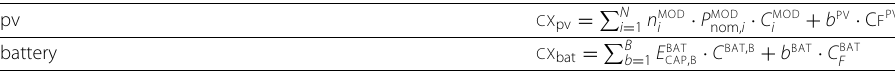
Finally, the CAPEX is composed of the PV and battery investment costs. The